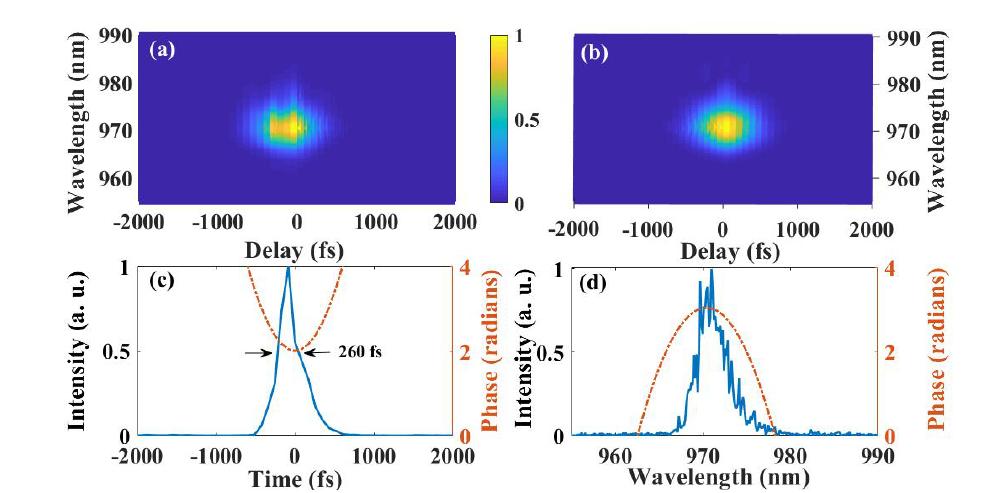
Figure 4. ( a ) Measured trace, ( b ) retrieved trace, ( c ) retrieved temporal profile, and ( d ) retrieved spectrum from the SHG-FROG with the best error value of